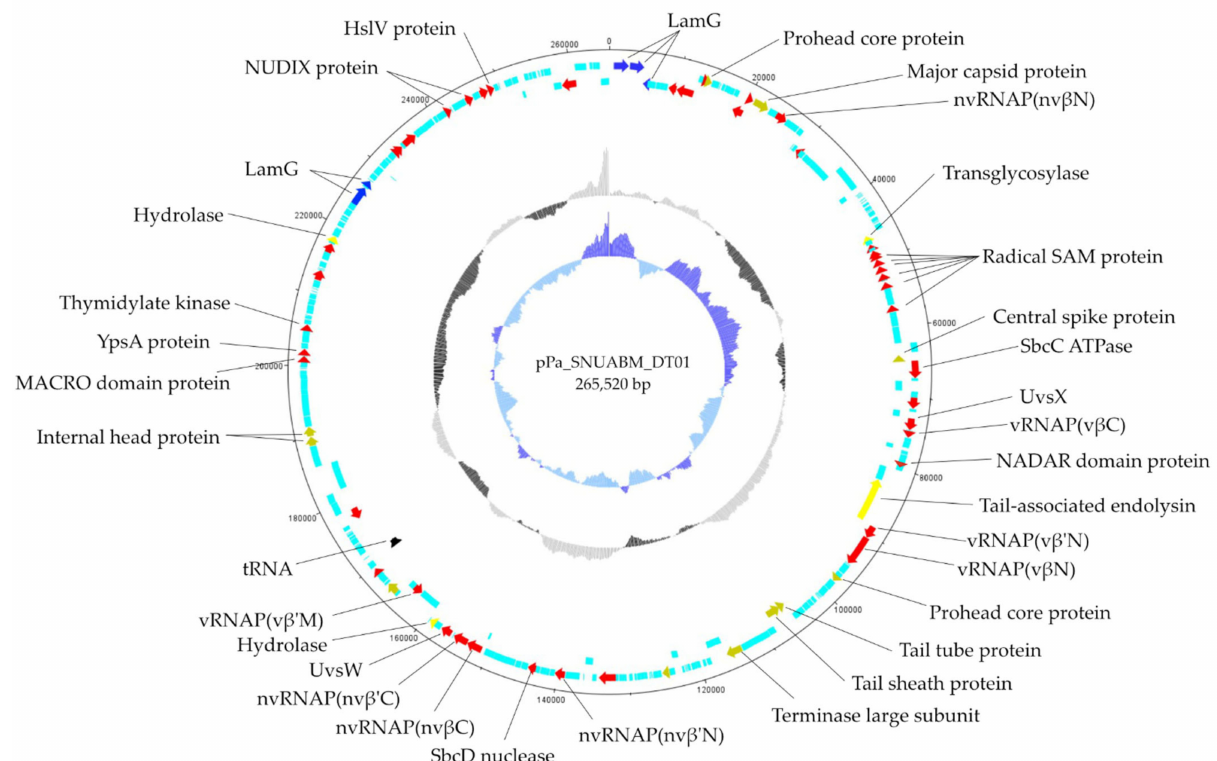
Figure 3. Genome map of pPa_SNUABM_DT01. The functional ORFs are indicated by specific colors according to their functional categories. The GC plot is indicated by the black and grey hologram, and the GC skew is demonstrated with the blue hologram. Red: nucleotide-metabolism-related ORFs; Yellow: lysis related ORFs; Green: structure-and-packaging- related ORFs. Black: tRNA; Sky-blue: hypothetical